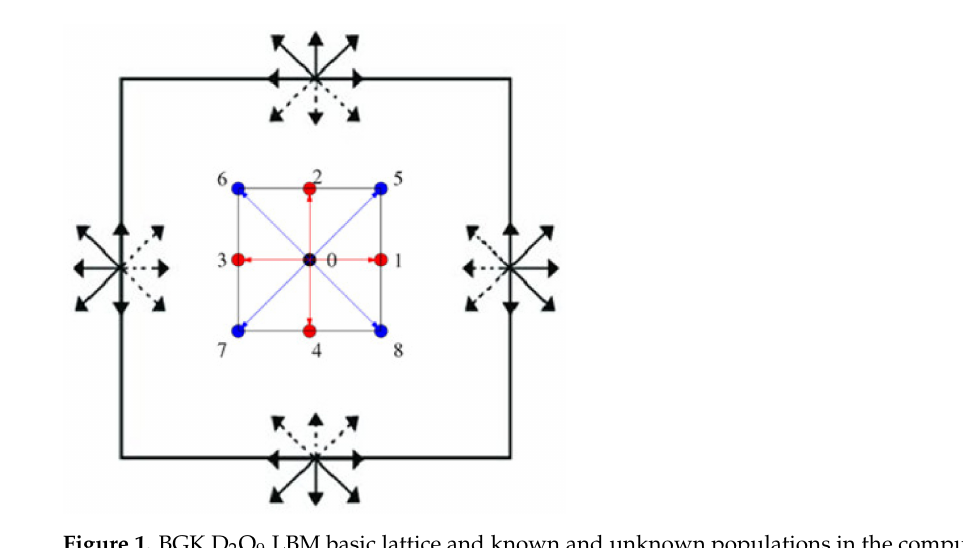
Figure 1. BGK D 2 Q 9 LBM basic lattice and known and unknown populations in the computational domain.